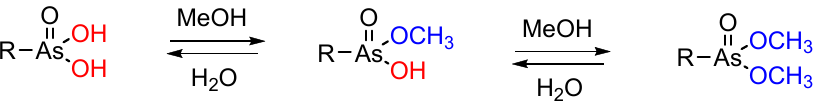
Figure 3. Methylation reactions of the arsonic group when methanol is present.